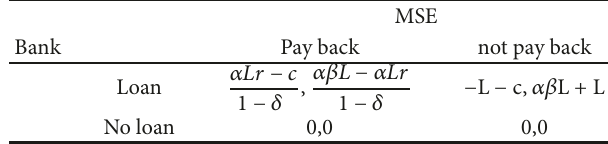
Table 1: Bank-MSE game matrix under complete